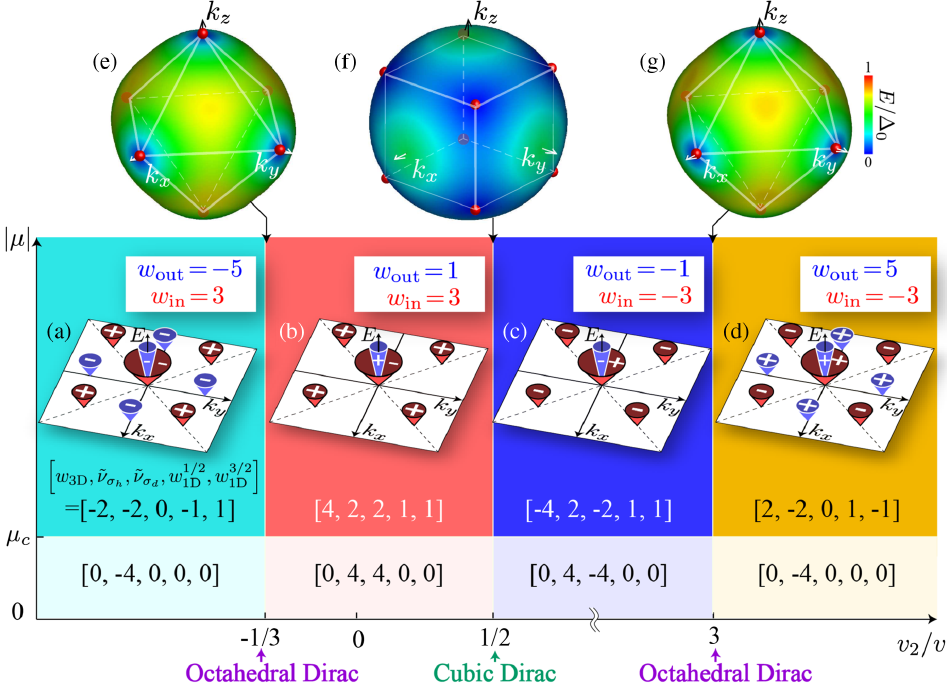
FIG. 10. Topological phase diagram of the A 1 pairing state for v 1 > 0 . The A 1 u reversal-invariant superconductor. From the O -group symmetry, it also supports the two different mirror Chern numbers ˜ ν σ h the rotation 1D winding number w j z 1 . If we consider v 1 < 0 , the winding numbers w 3 D the location of a helical Majorana fermion in the surface Brillouin zone, which carries by the winding number (cid:2) 1 . The cones with blue and red in the j μ j > μ phase show the contributions from the outer and inner Fermi surfaces, respectively. These colors correspond c to the symbols in Fig. 9. The gap structures on the outer Fermi surface (e) v 2 ¼ 3 v 1 , (f) v 2 ¼ v 1 = 2 , and (g) v 2 ¼ v 1 = 2 . The red dots indicate the point node of the superconducting gap. Here, μ ¼ − 2 m 0 , β 0 . 64 v 2 1 =m 0 for